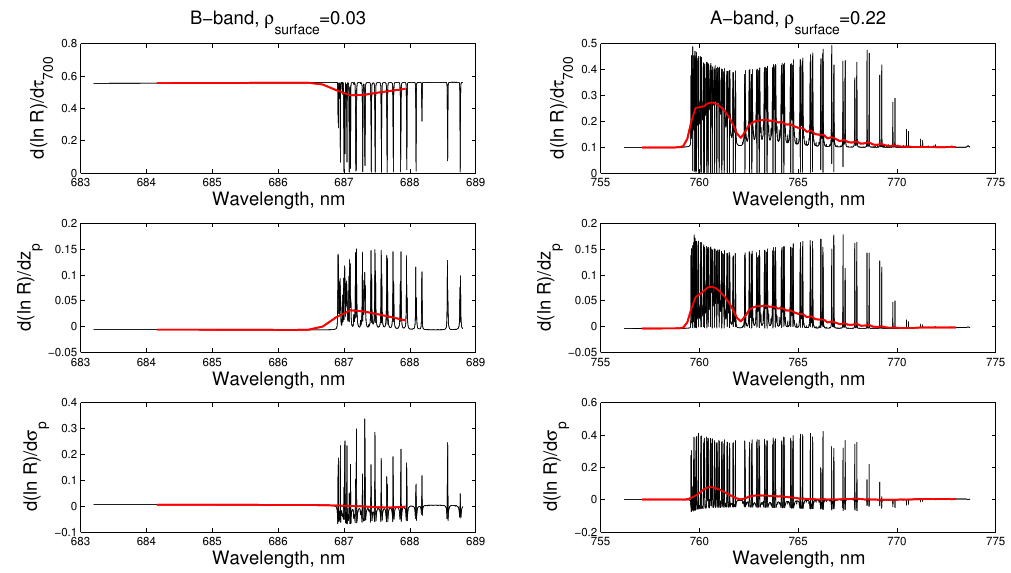
Fig. 2. Same as Fig. 1, but for a high contrast surface with ρ B =0.03 and ρ A =0.22. Note, however that the respective scales may differ.